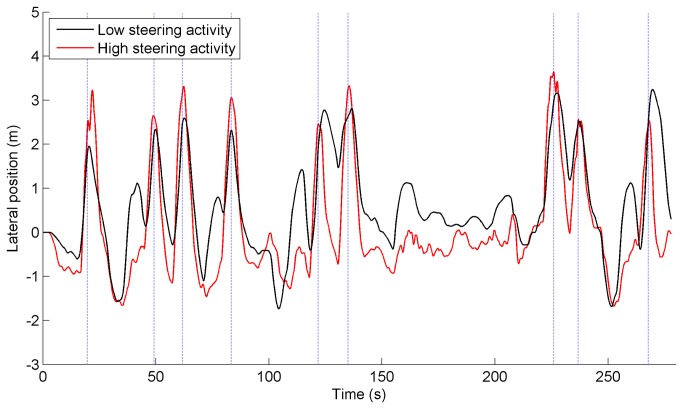
Lateral position versus time of two selected participants in session 4.One selected participant had very active steering, whereas the other had very smooth steering. Positive = lateral position to left with respect to right-lane center, negative = lateral position to right with respect to right-lane center. The dotted vertical lines indicate when the participant passed one of the nine static obstacles.